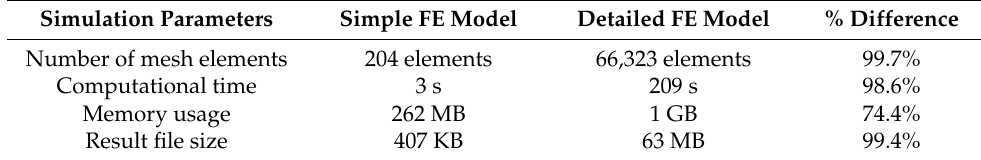
Table 3. Comparison between simplified FE model and detailed FE model of MFC.